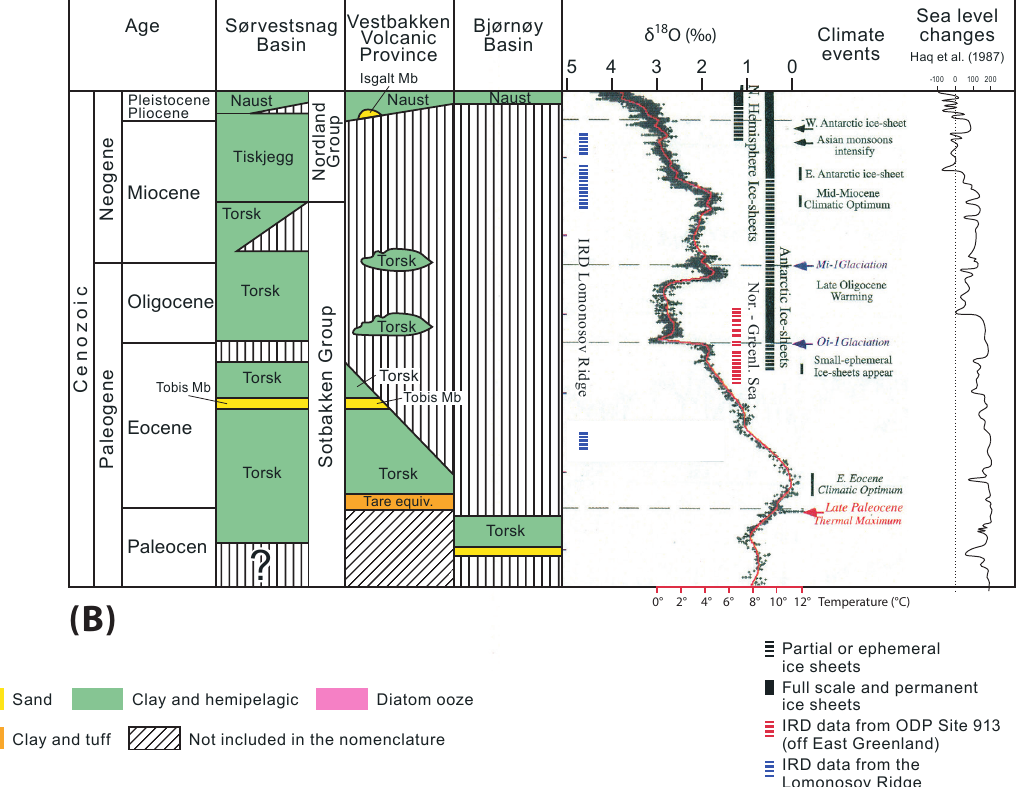
Figure 7. (A) General view of the late Paleogene and Neogene lithostratigraphy for Denmark, the North Sea and Norwegian Sea shelf (modified after Rundberg & Eidvin, 2005; Rasmussen et al., 2008; Eidvin et al., 2010, 2013d, 2014). (B) General view of the Paleogene and Neogene lithostratigraphy for the western Barents Sea (modified after Eidvin et al., 2013d, 2014). On the right-hand side of the diagrams there is added paleoclimatic data including a global deep-sea oxygen curve and periods with ice sheets in the Antarctica and northern hemisphere (after Zachos et al., 2001) and a global sea-level curve after Haq et al. (1987). Periods with deposition of IRD at ODP Site 913 (off East Greenland; Eldrett et al., 2007) and on the Lomonosov Ridge (Arctic Ocean; Backman et al., 2006; Moran et al., 2006; St. John, 2008) are also indicated.